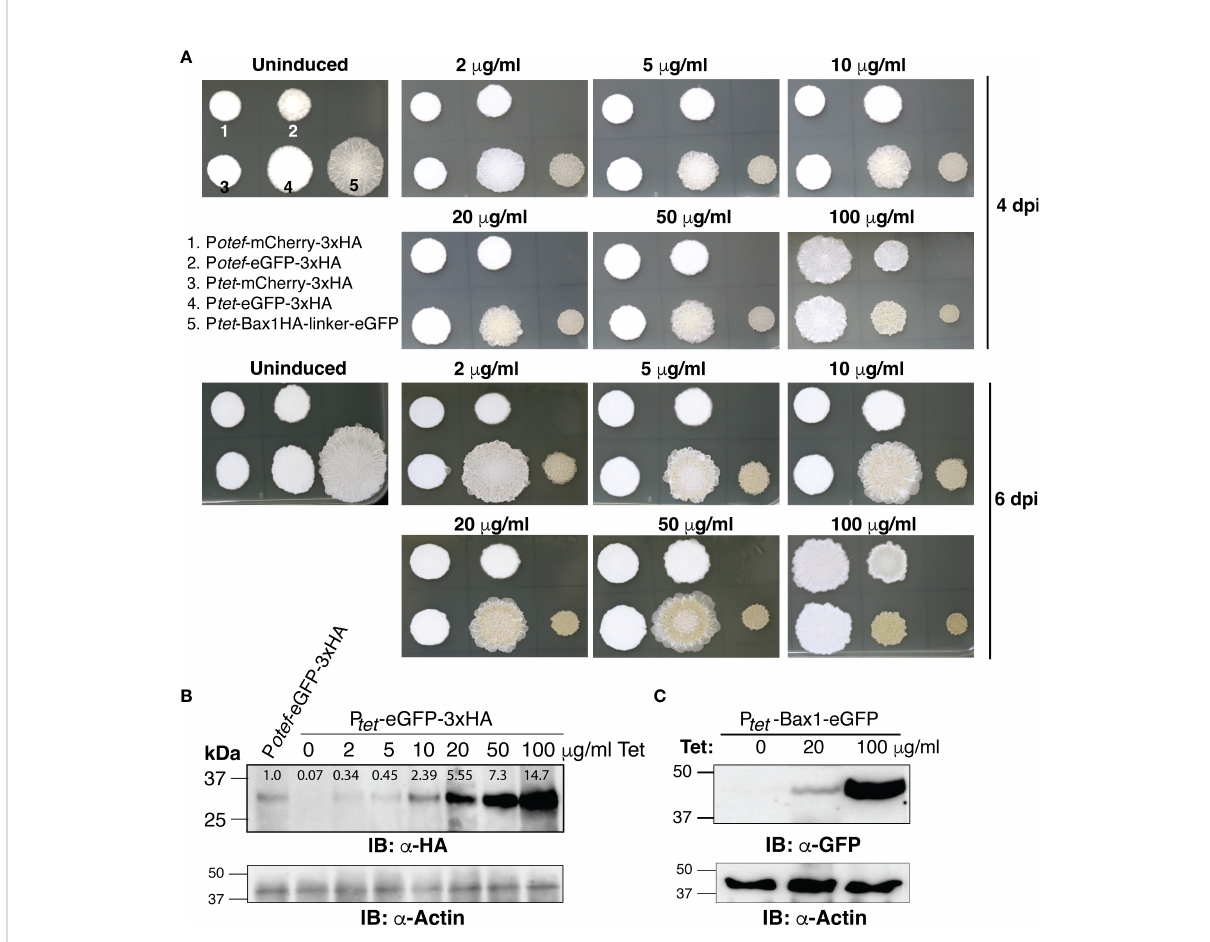
FIGURE 4 Dose-dependent induction of gene expression by TetON system. (A) The phenotype of fungal growth on the 4 th and 7 th day of indicated U. maydis strains grown on PDA+CBX ± Tet (2, 5, 10, 20, 50, and 100 m g/ml). (B, C) Immunoblot performed with a -HA, a -GFP, and a -Actin antibodies on total protein extracts of sporidia harvested from 4 days old, indicated